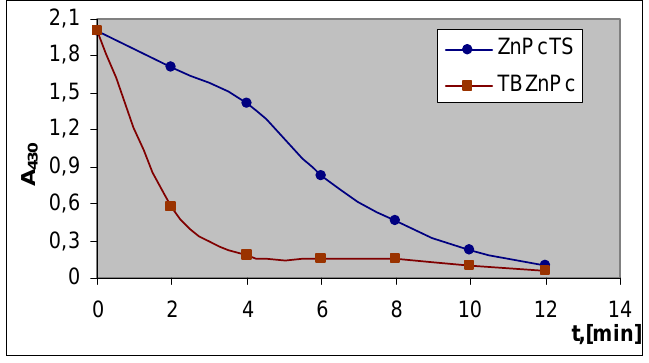
FIGURE 2 . Time course of photobleaching of DPBF by TBZnPc and ZnPcTS.